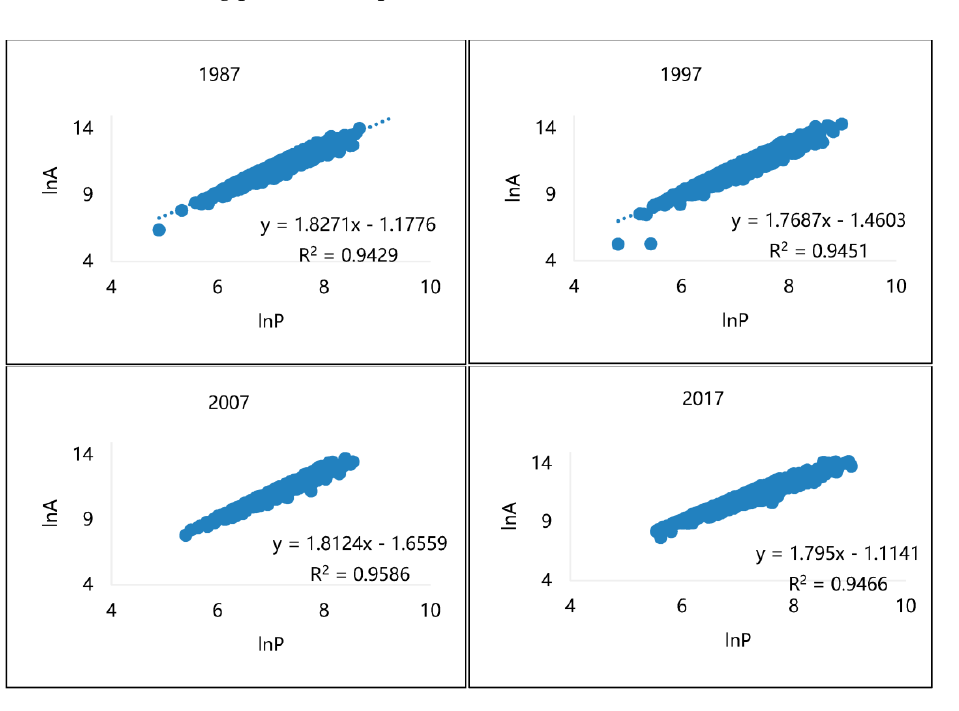
Figure 9. P - A diagram of the manufacturing production spaces in the PRD in 1987–2017. Table 4. Fractal dimension and stability index of the manufacturing production spaces in 1987 –